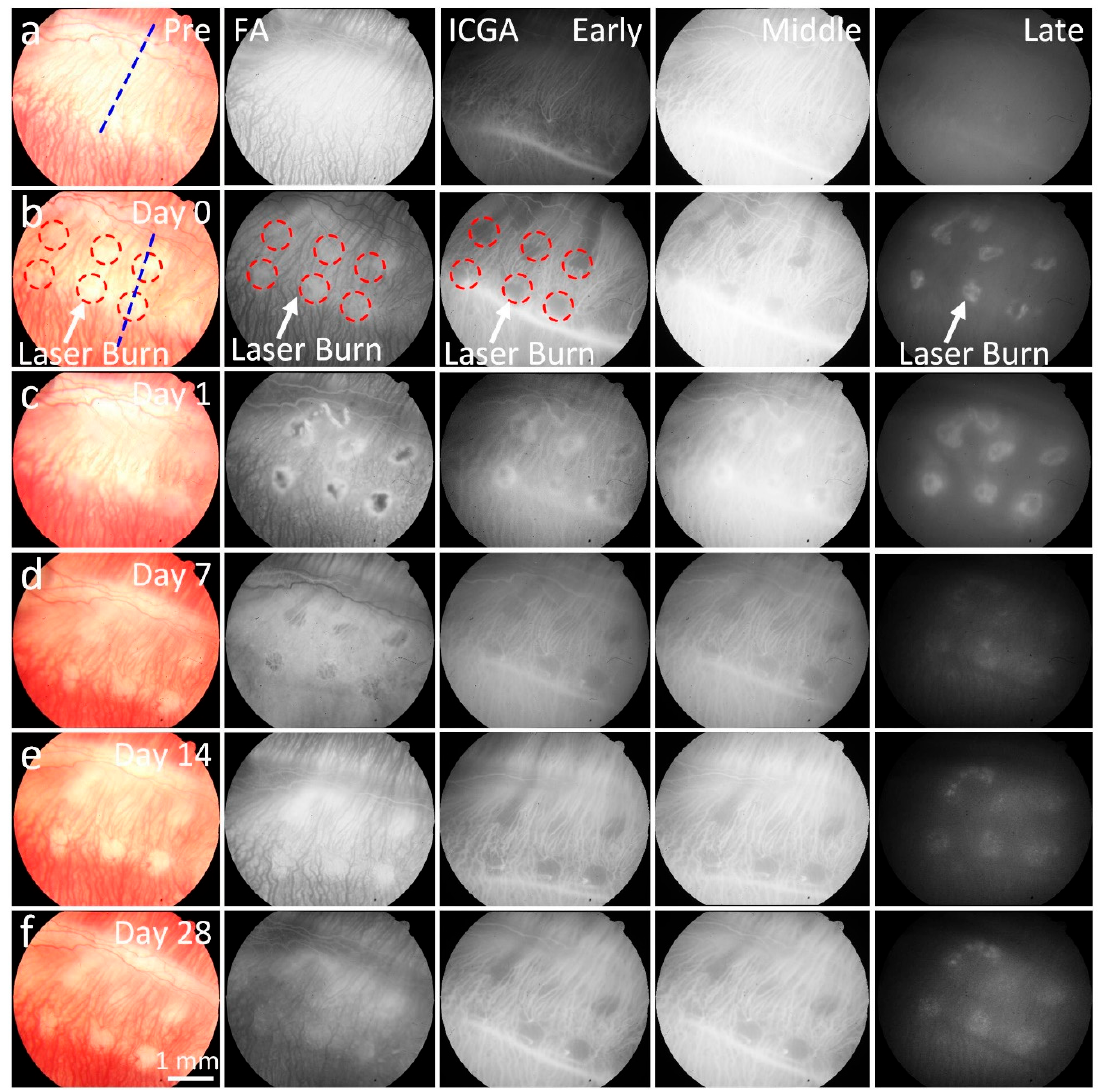
Figure 1. In vivo color fundus photography, fluorescein angiography (FA) and indocyanine green angiography (ICGA) imaging from the right eye of a rabbit with choroidal vascular occlusion (CVO). ( a ) Baseline color fundus, FA, and ICGA (early, middle, and late phases) images acquired before laser-induced CVO, showing clear microvasculature. ( b – f ) Images of CVO acquired post laser illumination at di ff erent time points: day 1, 7, 14, and 28. Red circles indicate the position of CVO; blue dotted line shows the selected scanning line for OCT. These images show reduced color intensity (color fundus) or fluorescent intensities (FA and ICGA) at the corresponding location of CVO (white arrows).